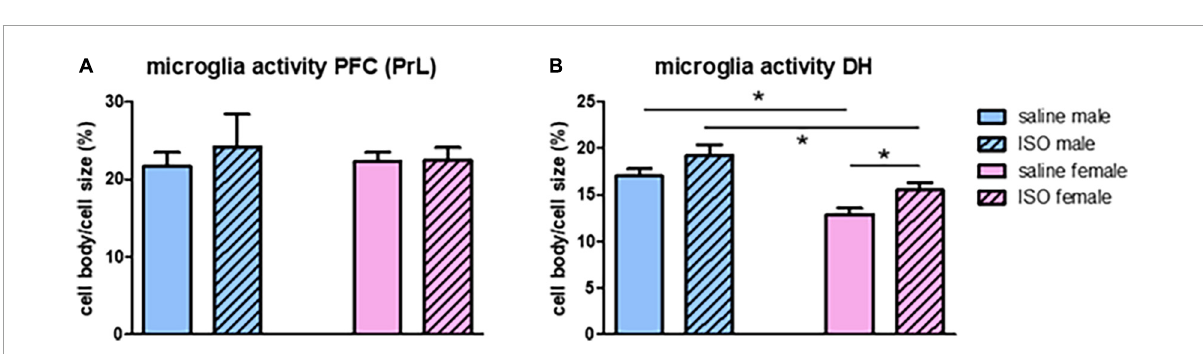
FIGURE3 Microglia activity in the prefrontal cortex (PFC; A ) and the dorsal hippocampus (DH; B ) in the different experimental groups ( n = 8,5,7,10 in saline male, ISO male, saline female and ISO female rats, respectively). ISO, isoproterenol. *Significant difference between indicated groups.